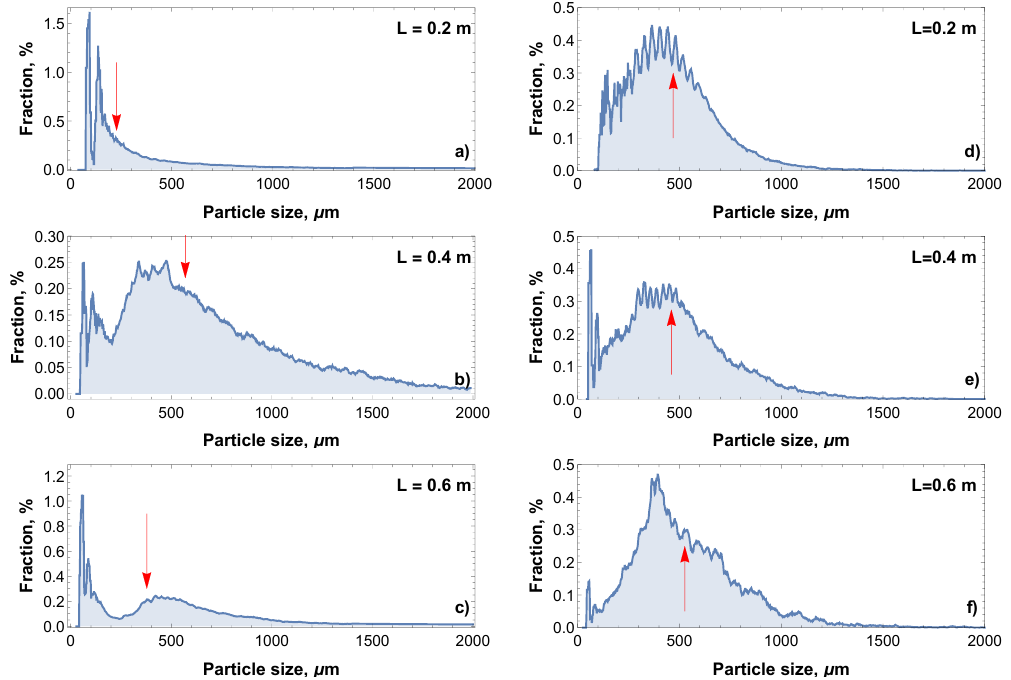
Figure 2. The measured size distributions of the aerosol particles at different distances from the nozzle for the CWS ( a – c ) and CWSP ( d – f ). The first moment of the distribution corresponds to the size shown by red